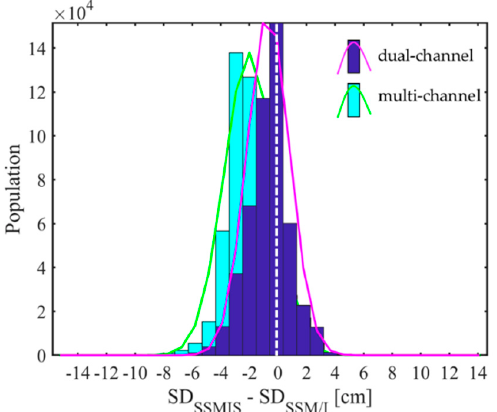
Figure 10. Histograms from the two different algorithms. Cyan and blue histograms represent the snow depth bias distribution for the dual-channel algorithm and multichannel method, respectively. The bias (SD SSMIS ‒ SD SSM/I ) is the difference between SSM/I snow depth and SSMIS snow depth. A white dashed line denotes that the mean bias is zero. SD is snow depth in centimeters. The histogram bin width is 1 cm.